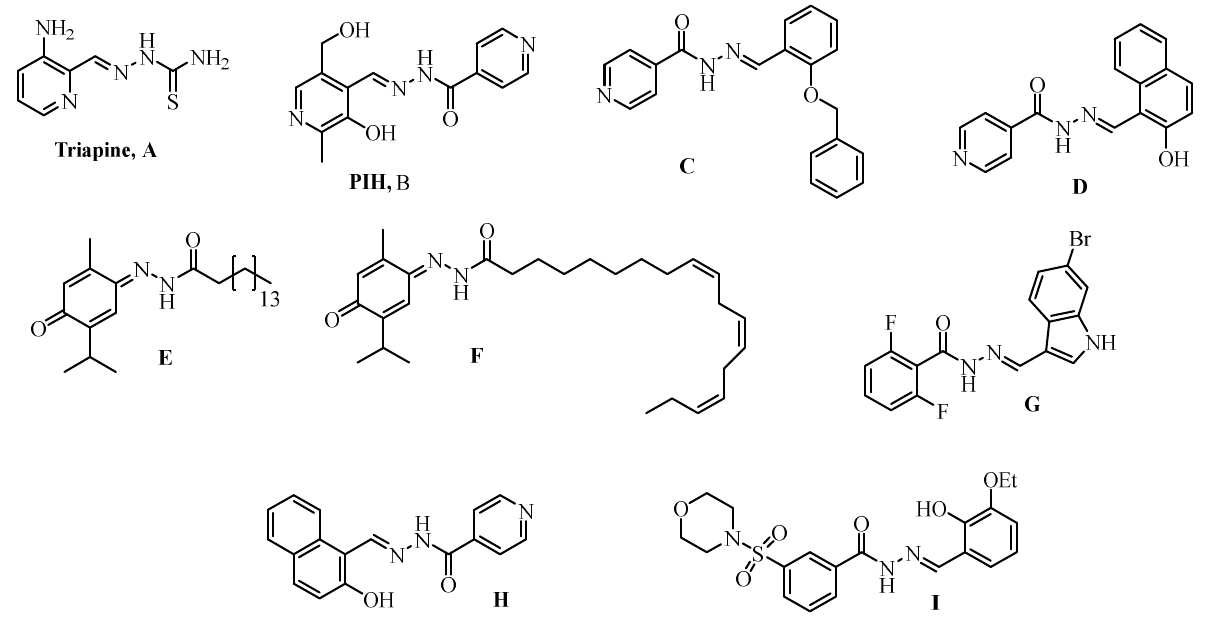
Figure 1. Hydrazones with anti-tumoral activity.